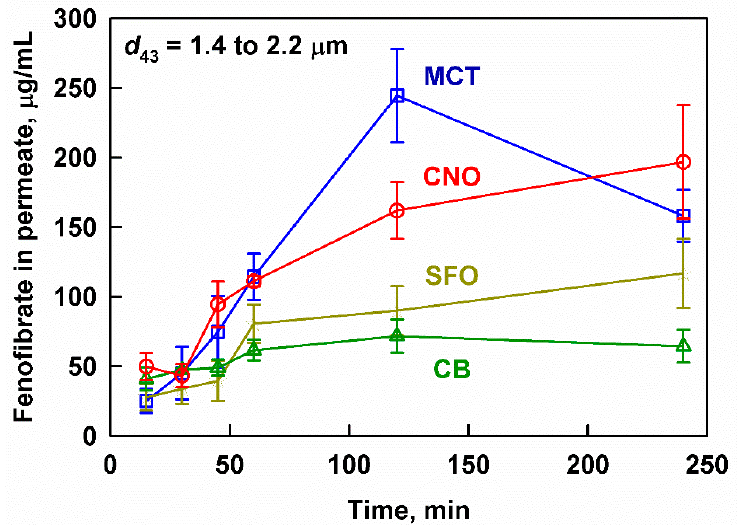
Figure 3. Fenofibrate measured in the aqueous phase after filtration as a function of the digestion time at simulated intestinal conditions of MCT (blue squares), CNO (red circles), SFO (yellow stars) and CB (green triangles) emulsions prepared by sonication ( d 43 between 1.4 and 2.2 µm). Emulsifier concentration = 1 wt% for all emulsions.